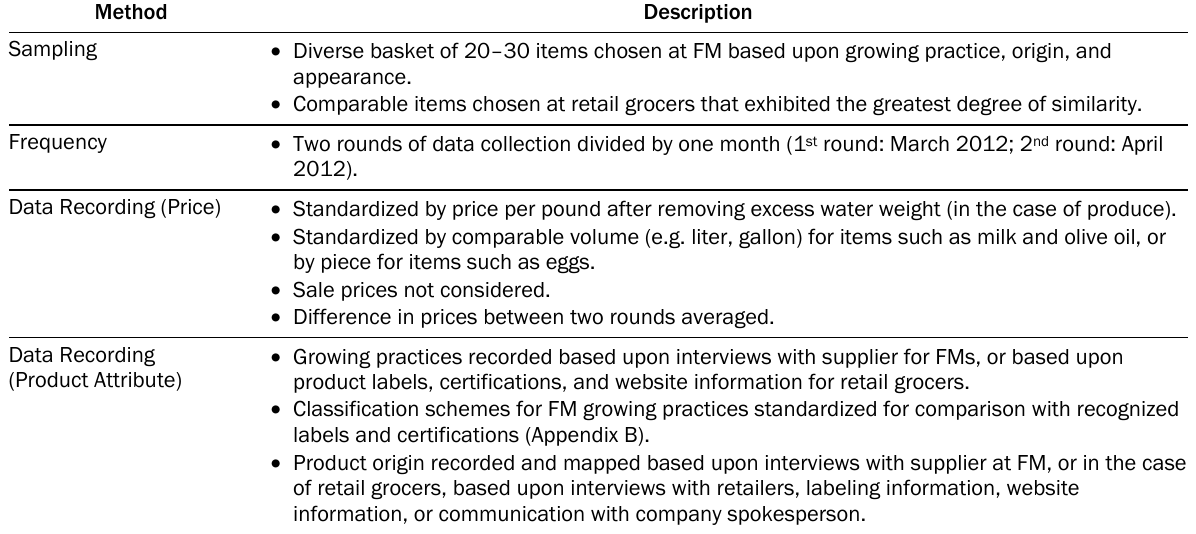
Table 1–A. Summary of Price Comparison